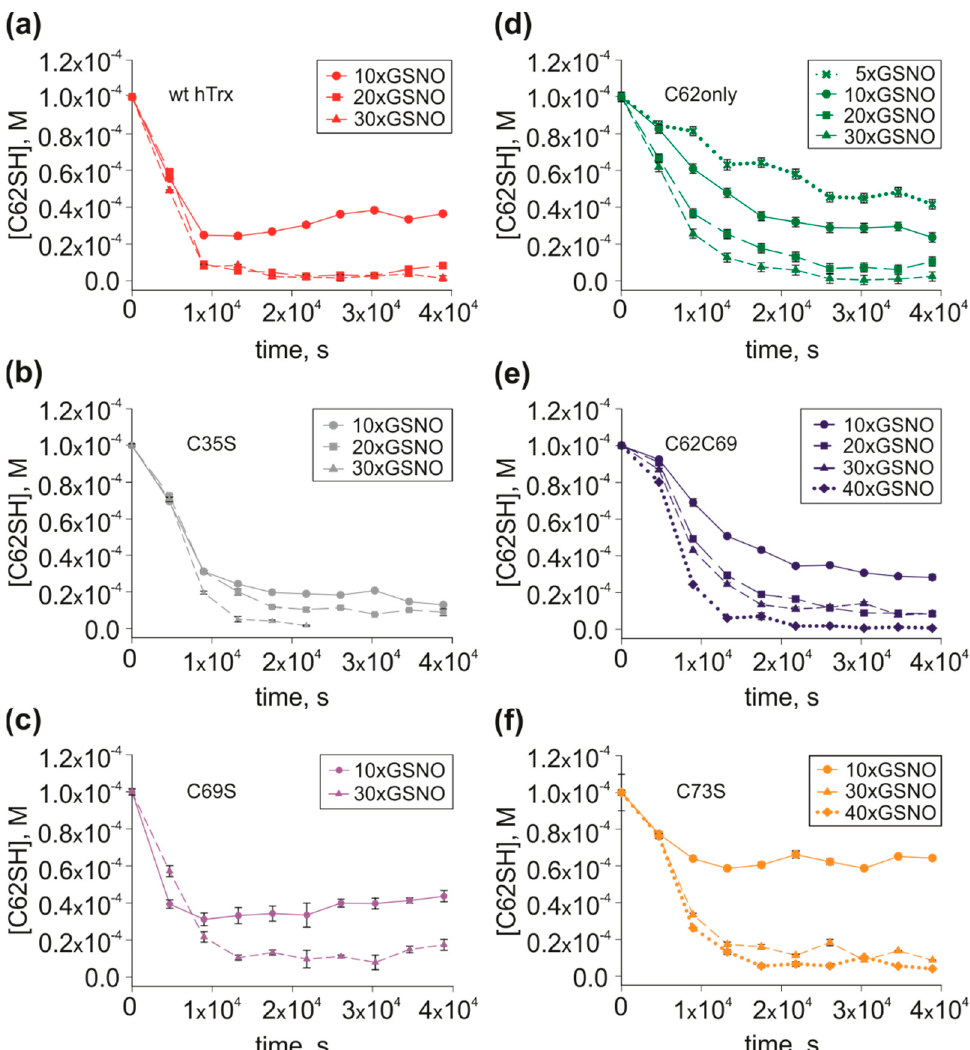
Figure 4. C62SH concentration decay. S-nitrosation kinetics of hTrx mutants (100 µM) with increasing GSNO concentration. C62SH concentration was calculated based on the C62SH signal area. On the left, C62SH concentration decay of wild type hTrx ( a ), C35S ( b ), and C69S ( c ) mutants. The oxidation of C62SH in the mutants is similar to that in wild type hTrx. On the right, C62SH concentration decay of C62only ( d ), C62C69 ( e ), and C73S ( f ) mutants showing a slower decay if compared with C62SH in wild type hTrx. These observations highlight the importance of C73 to C62 S-nitrosation and demonstrate that oxidation of the redox site and C69 do not affect the C62 S-nitrosation rate. The experimental error for each experimental point was estimated from the standard deviation of the spectral noise for one experiment.